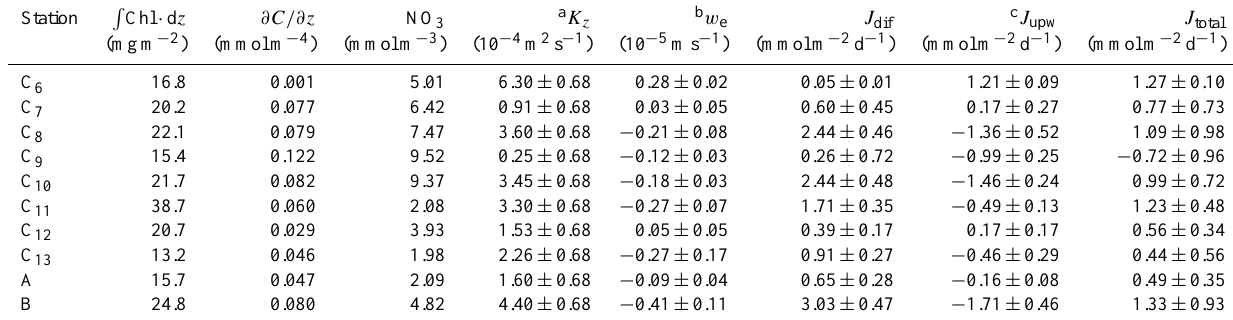
Table 1. Comparisons of integrated chlorophyll a ( R Chl · d z ), nitrate gradient ( ∂C/∂z) , nitrate concentration (NO 3 ) , vertical diffusivity ( K z ) , upwelling velocity ( w e ) , diffusive nitrate flux ( J dif ) , upwelled nitrate flux ( J upw ) and total nitrate flux ( J total ) for transect stations C 6 − 12 and incubation stations A and B at ∼ 1% light depth ( ∼ 100m depth).